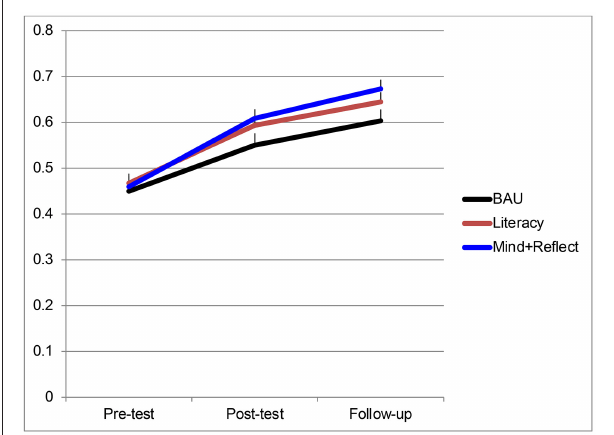
FIGURE 1 | Performance on the EF composite as a function of time and condition. Bars represent standard errors. BAU, Business as Usual; Mind + Reflect, Mindfulness plus